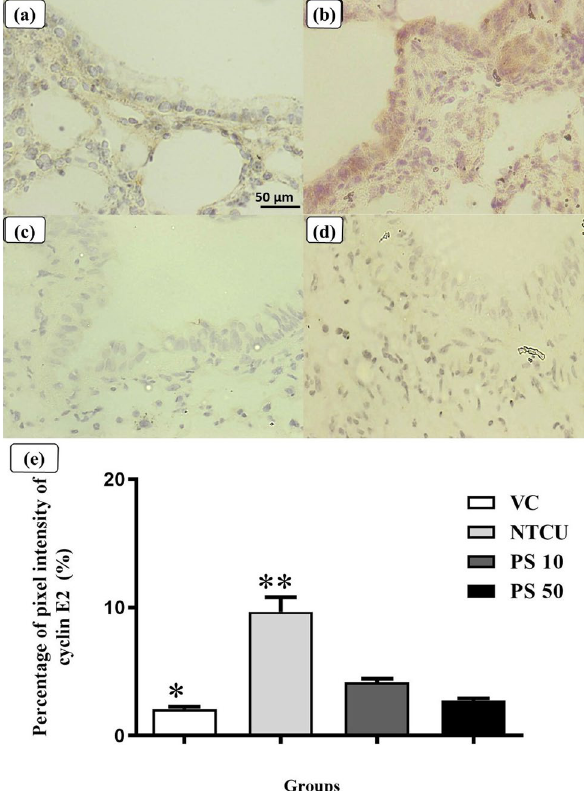
Figure 4. Immunochemistry staining of cyclin E2 cell cycle marker for each group focused on the bronchial epithelium layer of the lung. The immunopositive area of cyclin E2 is represented by the brown staining. ( a ): Low cyclin E2 expression in the VC group. ( b ): Strong nuclear and cytoplasmic cyclin E2 expression at the bronchial epithelium layer in the NTCU group. ( c ): PS 10, and ( d ): PS 50 depict very low expression of cyclin E2 at the bronchial epithelium layer. ( e ) showed the quantification of cyclin E2 as a percentage of pixel intensity (%) using the Fiji/Image J software. *Statistically significant differences between VC and NTCU, PS 10, and PS 50 ( p < 0.05). **Statistically significant differences between NTCU and VC, PS 10, and PS 50 ( p <